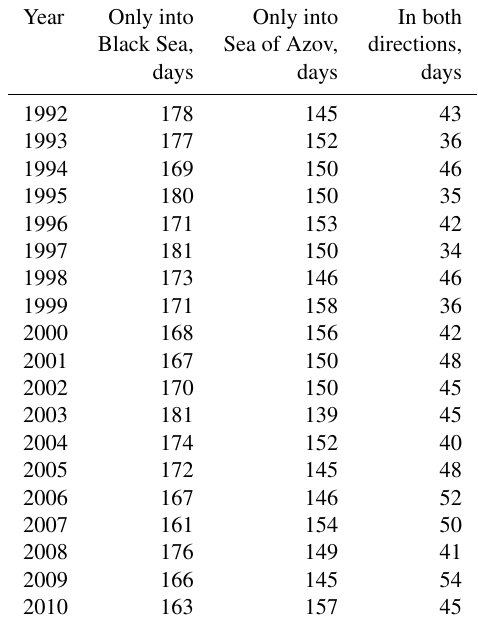
Table 1. The flow direction statistics in the Kerch Strait for the pe- riod from 1992 to 2010, obtained by the BSAS12 numerical model simulation. Year Only into Only into In both Black Sea, Sea of Azov, directions, days days days 1992